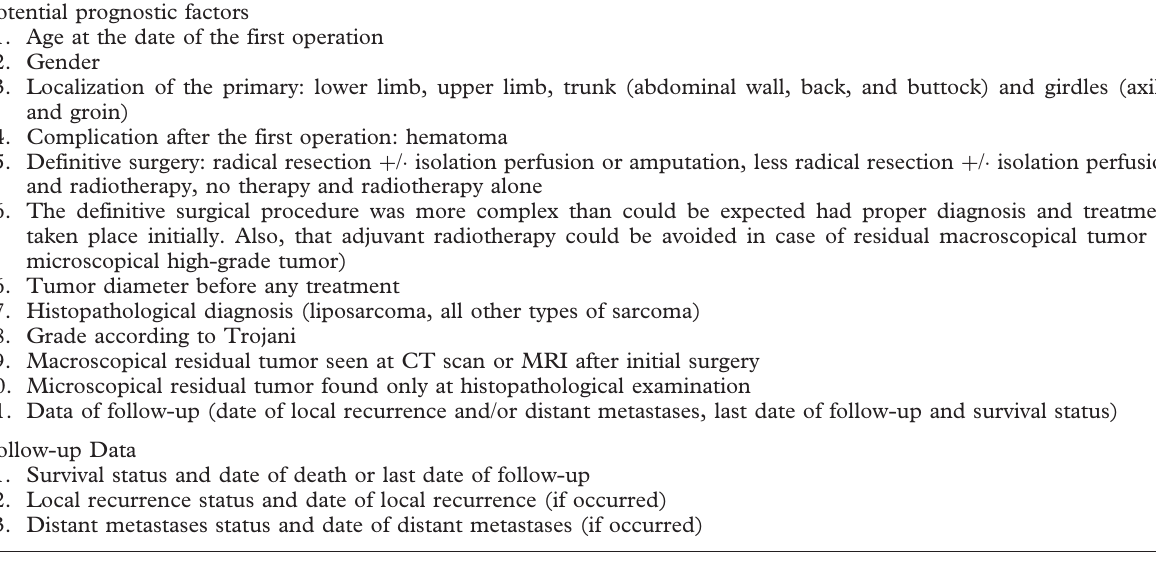
Table 2. Study parameters of 86 patients with an unplanned excision of soft tissue sarcoma